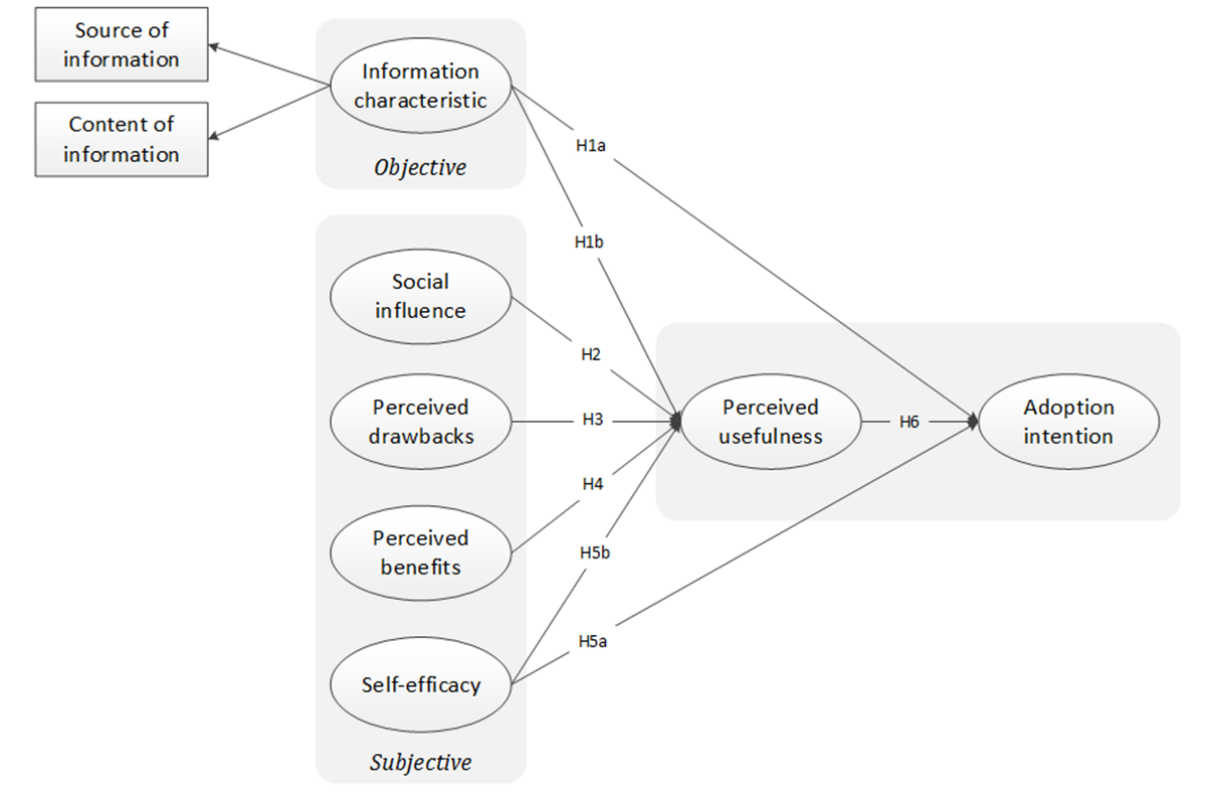
Figure 1. Integrated model based on the information adoption model and health belief model. H: